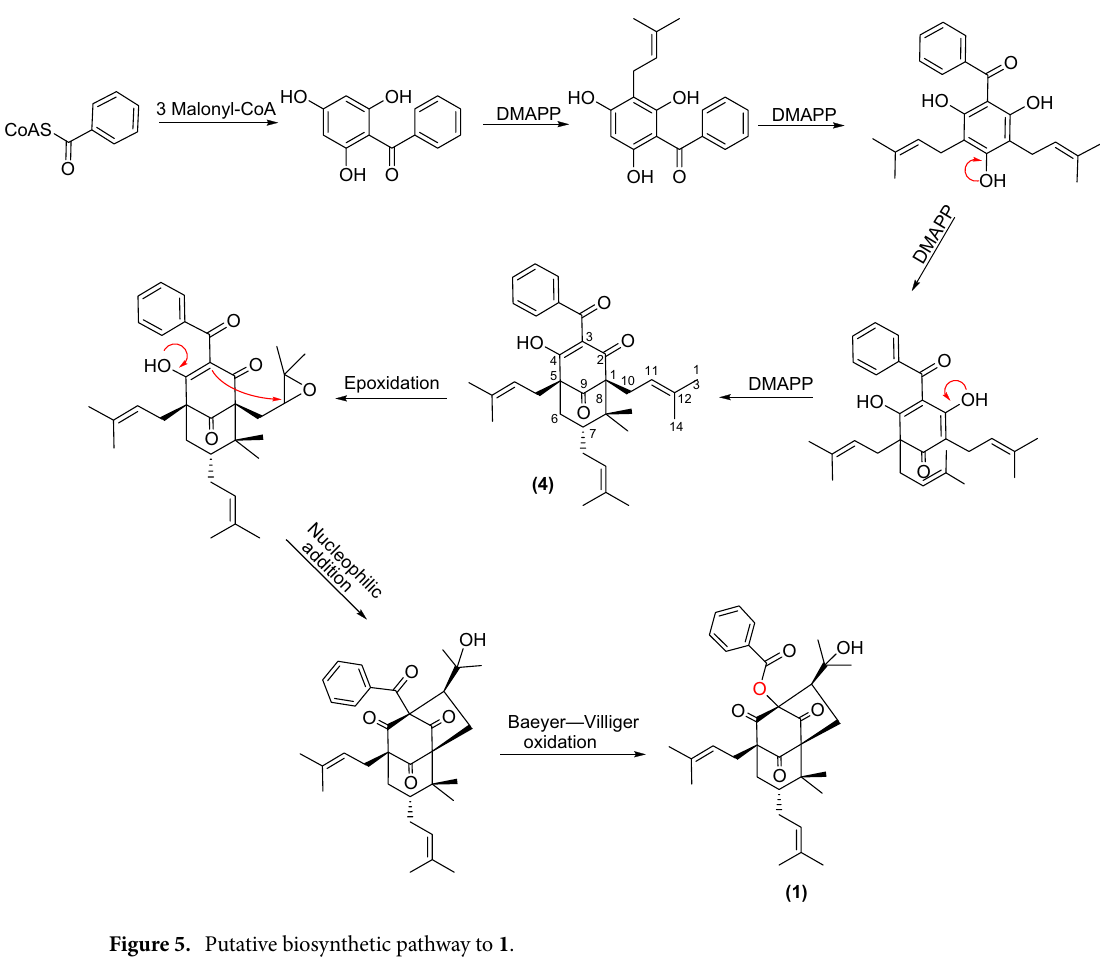
Figure 5. Putative biosynthetic pathway to 1 .